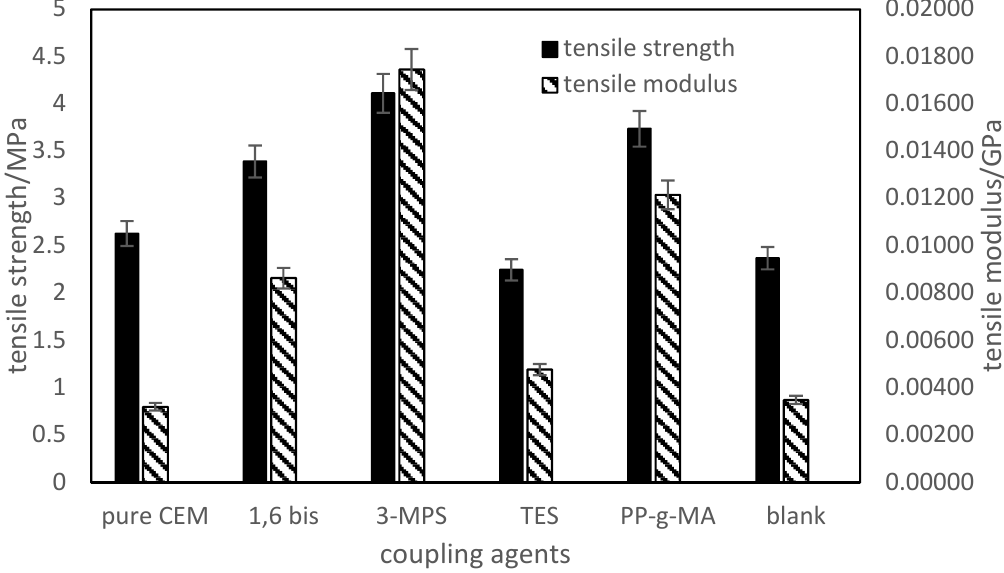
Figure 3. Tensile strength and tensile modulus of CEM composite with different modified GFs.